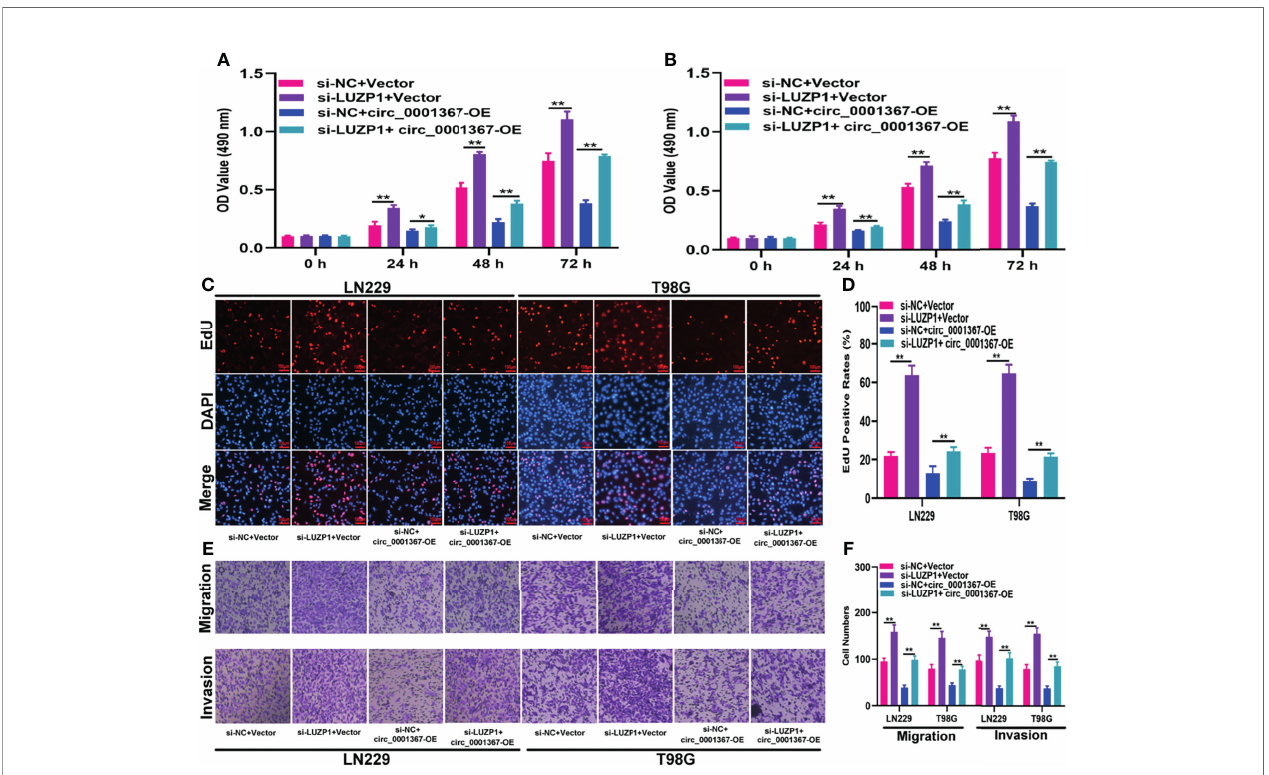
FIGURE 7 | LUZP1 downregulation restored the effect of circ_0001367 overexpression on glioma cells. (A, B) The proliferation of cells transfected with si-LUZP1, circ_0001367 or si-LUZP1 plus circ_0001367 was tested by MTT assay. (C, D) The proliferation of cells transfected with si-LUZP1, circ_0001367 or si-LUZP1 plus circ_0001367 was tested by EdU assay. (E, F) Transwell assay was conducted to measure the migration and invasion capacity of cells which transfected with si- LUZP1, circ_0001367 or si-LUZP1 plus circ_0001367. *P < 0.05, **P < 0.01.